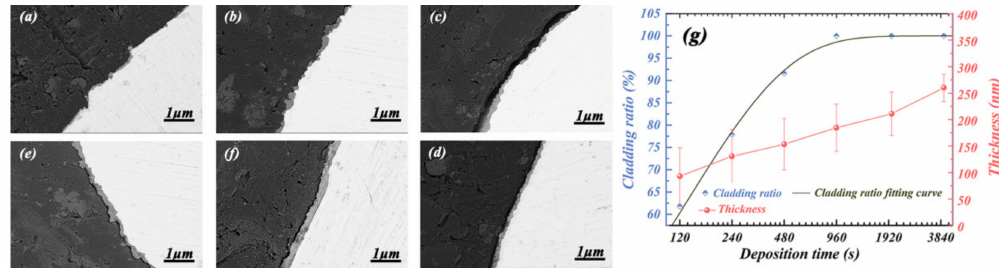
Figure 3. Cross-sectional images of Fe-6.5wt.%Si / SiO 2 composite particles after deposition for ( a ) 120 s, ( b ) 240 s, ( c ) 480 s, ( d ) 960 s, ( e ) 1920 s, and ( f ) 3840 s. ( g ) The relationships between the cladding ratio, SiO 2 insulation thickness, and deposition